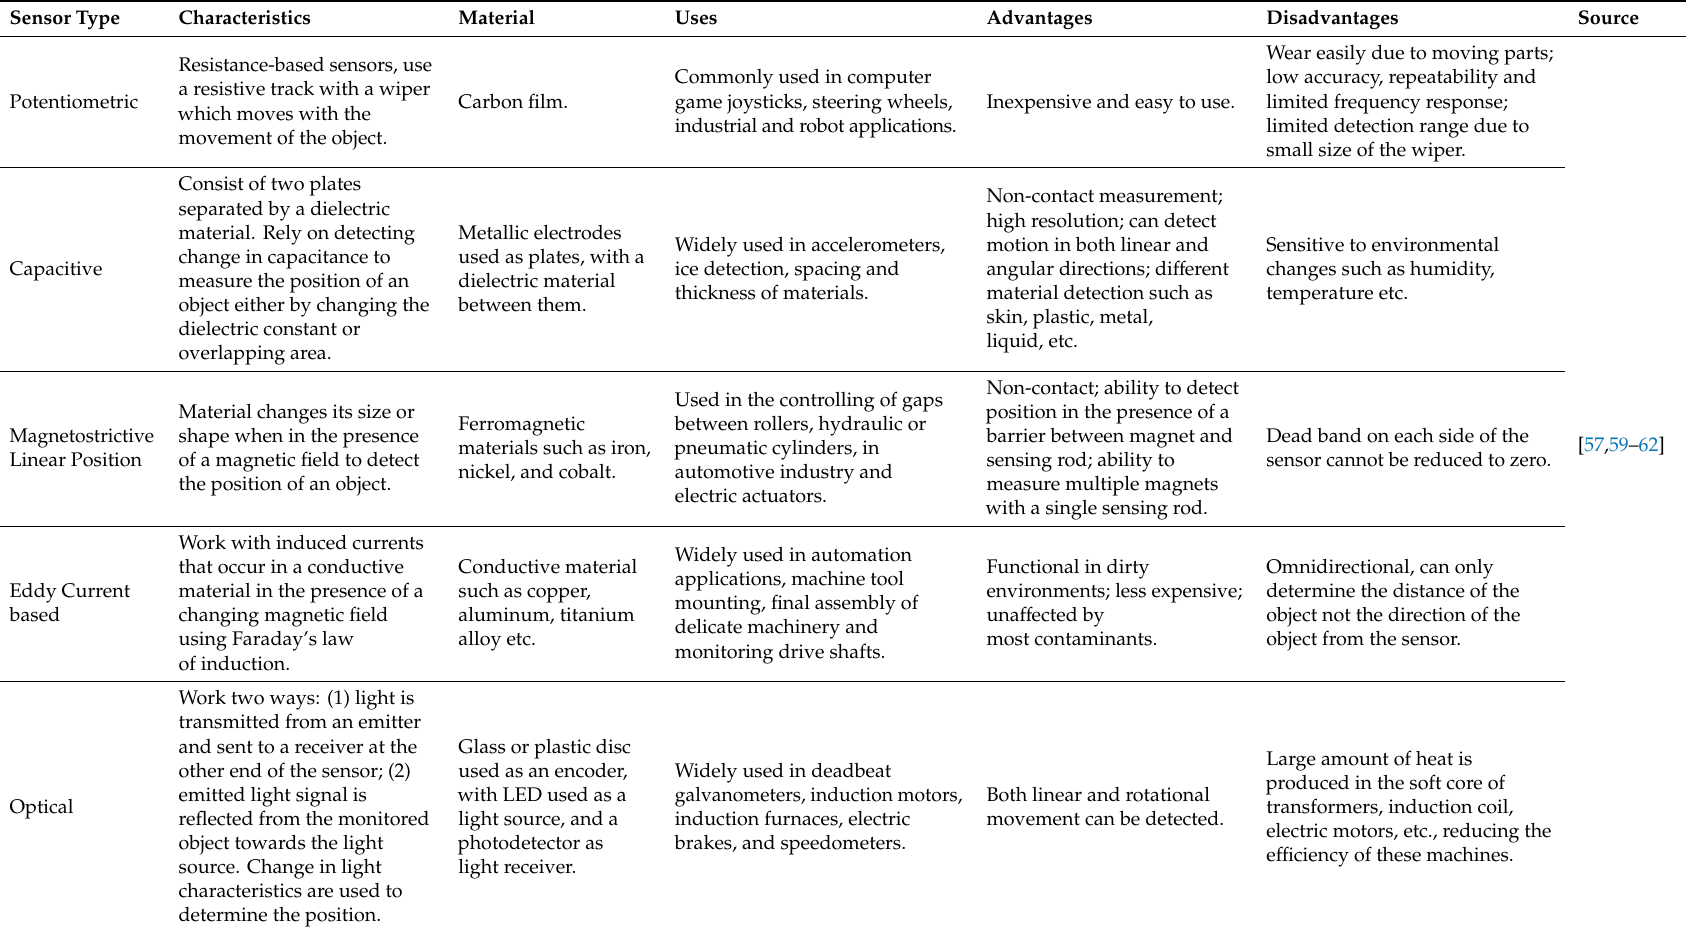
Table 4. Key features of position